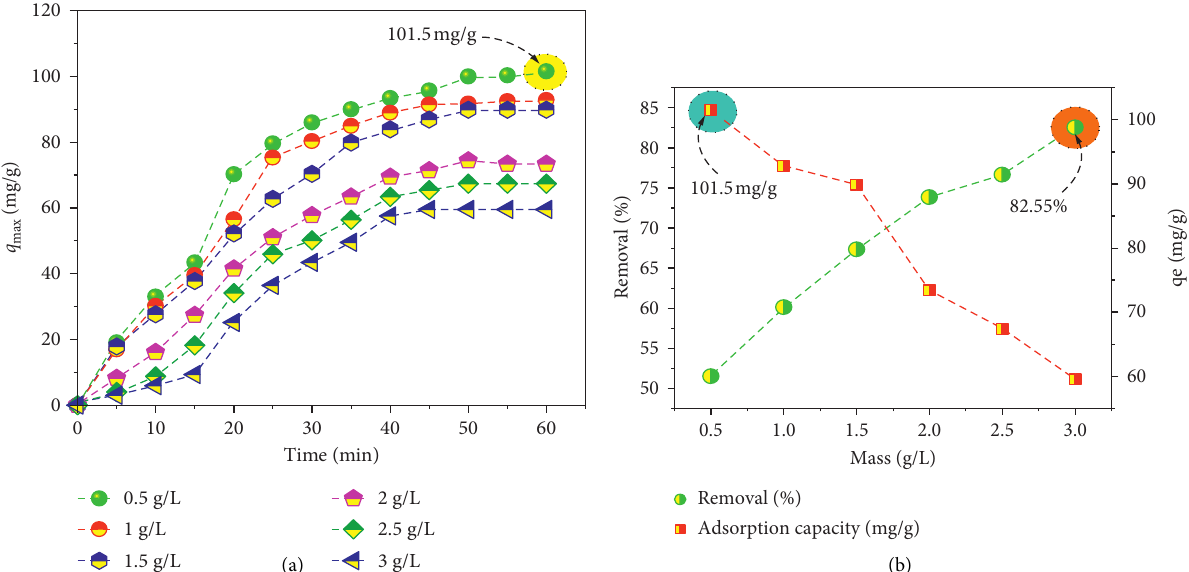
Figure 6: RDP mass effect on the RBB adsorption (a) and the optimal RDP mass during the adsorption phenomenon